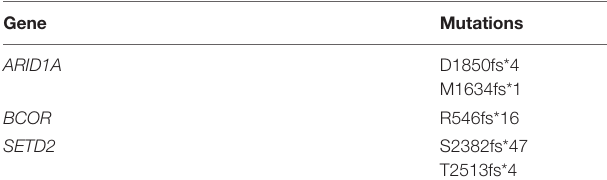
table 2 | Genetic alterations identified by sequencing. Gene Mutations